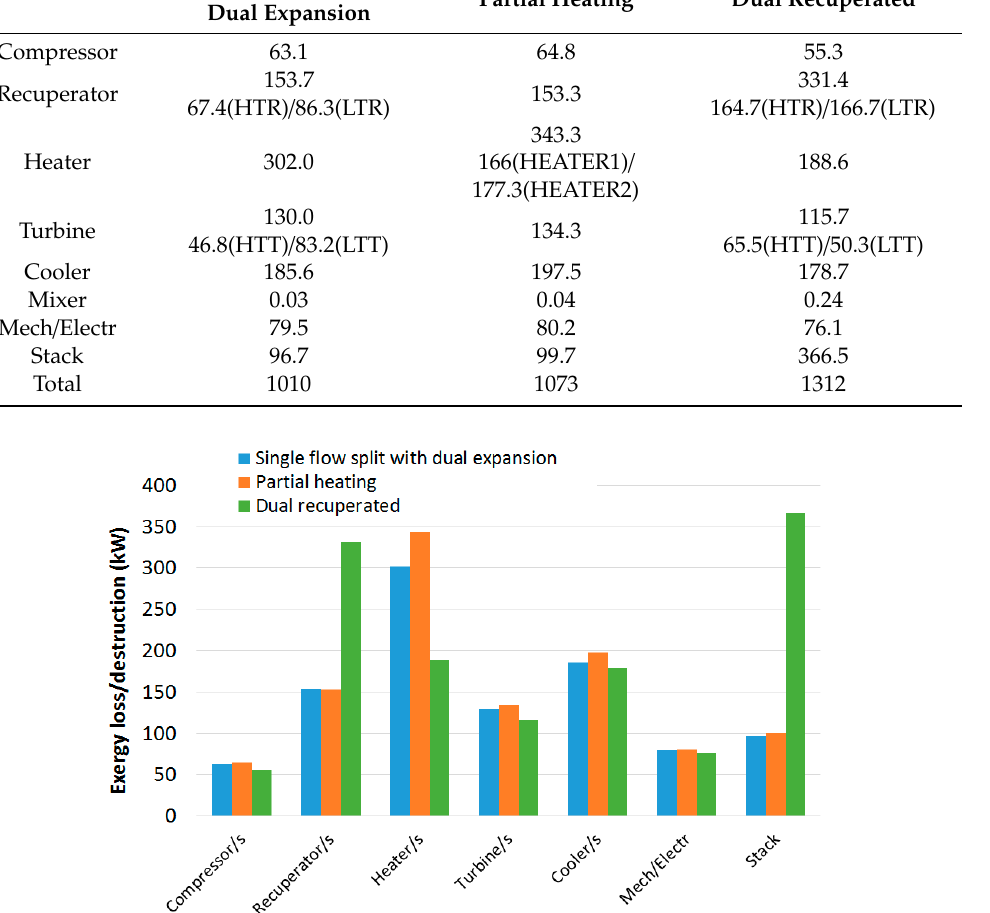
Figure 16. Exergy losses / destructions in plant components for the s-CO 2 power cycles: Single flow split with dual expansion (blue bars), partial heating (orange), and dual recuperated (green).